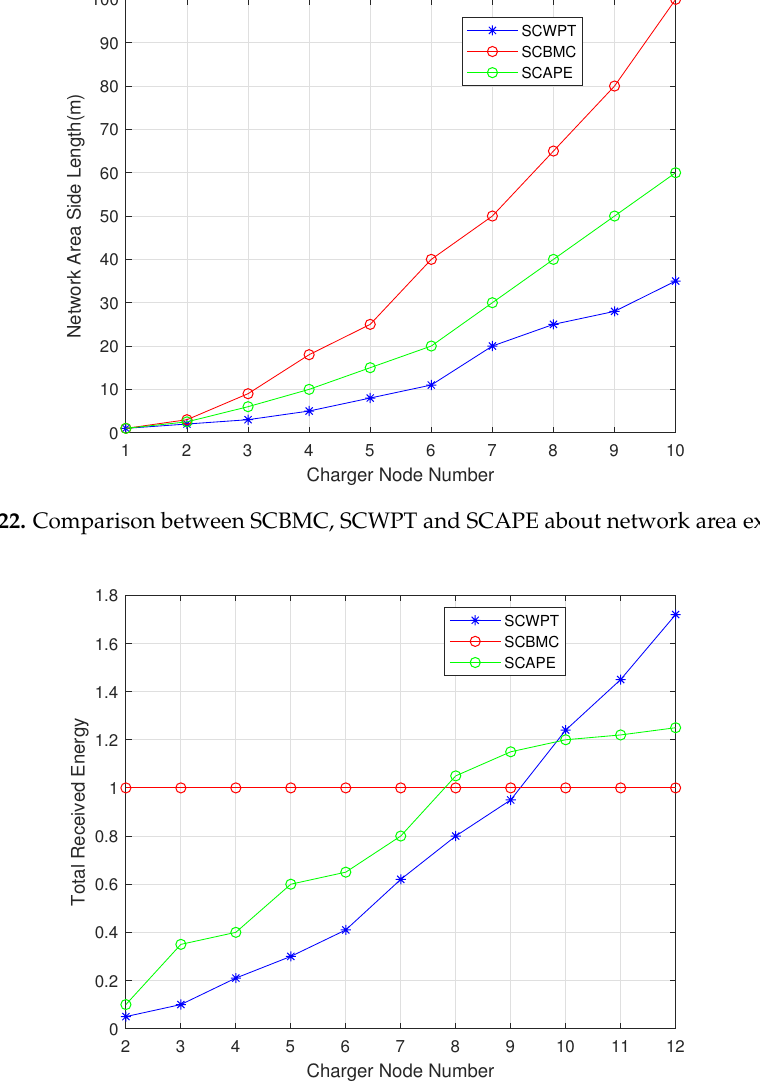
Figure 23. Comparison between SCBMC, SCWPT and SCAPE about total received